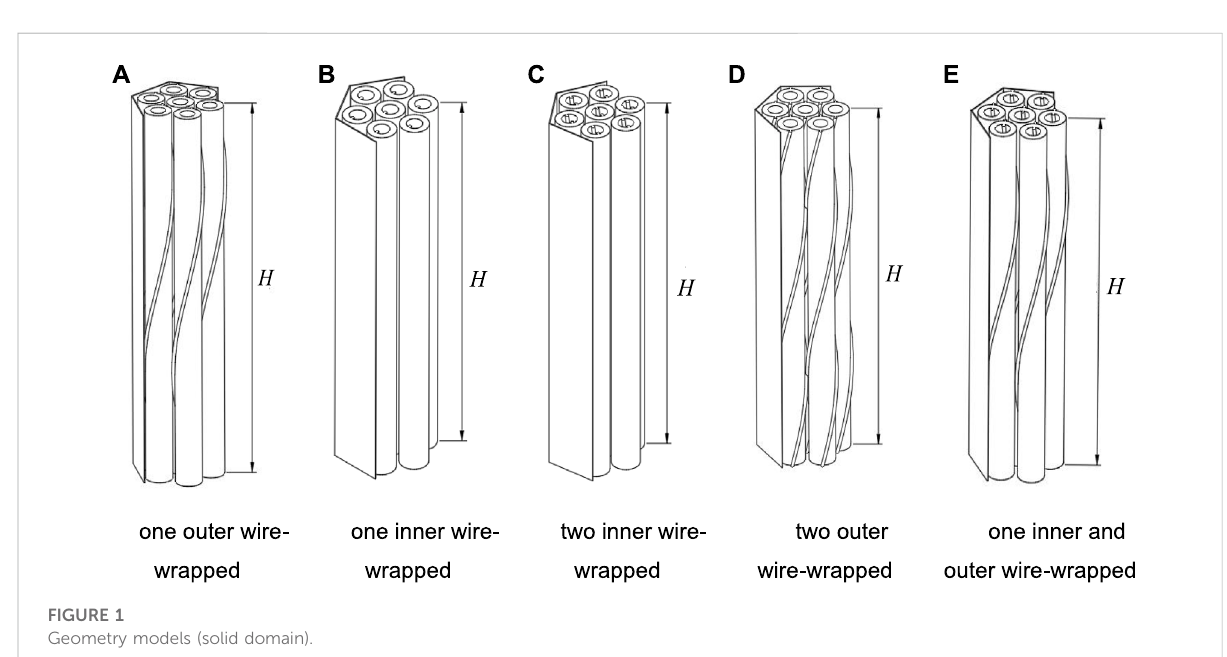
FIGURE 1 Geometry models (solid